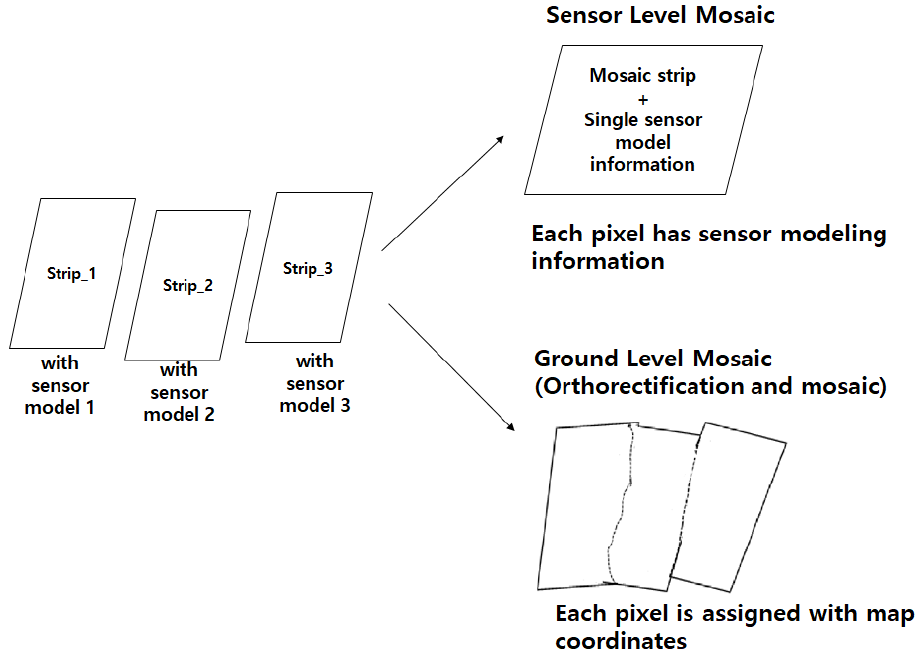
Figure 1. Sensor-level mosaic vs. ground-level mosaic.